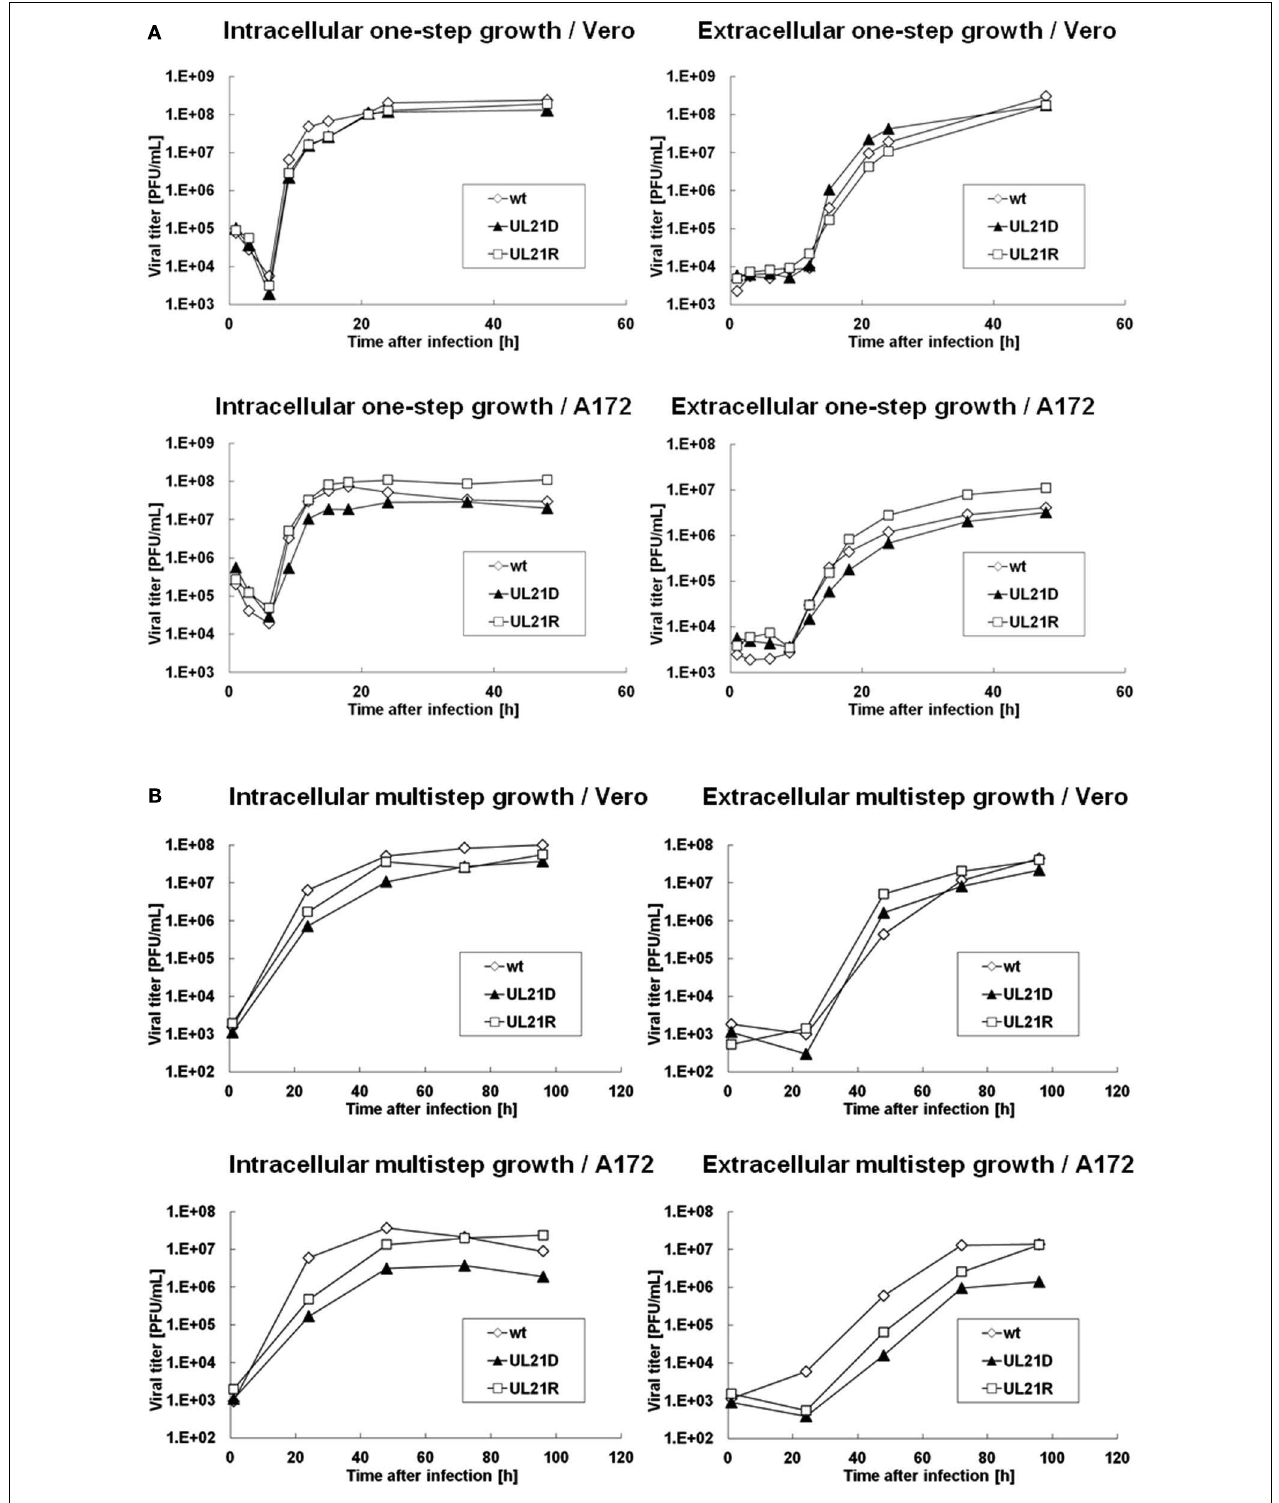
0.03 (B) . At the indicated times post-infection, the infected cells and supernatant were analyzed separately by plaque assay to determine the intracellular and extracellular viral yields,